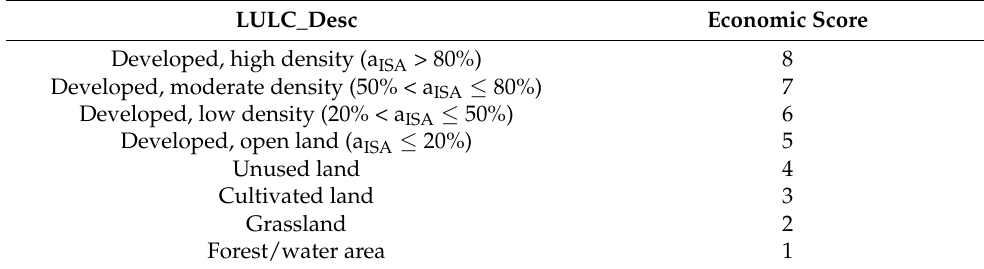
Table 4. Economic Vulnerability Score for each LULC type.